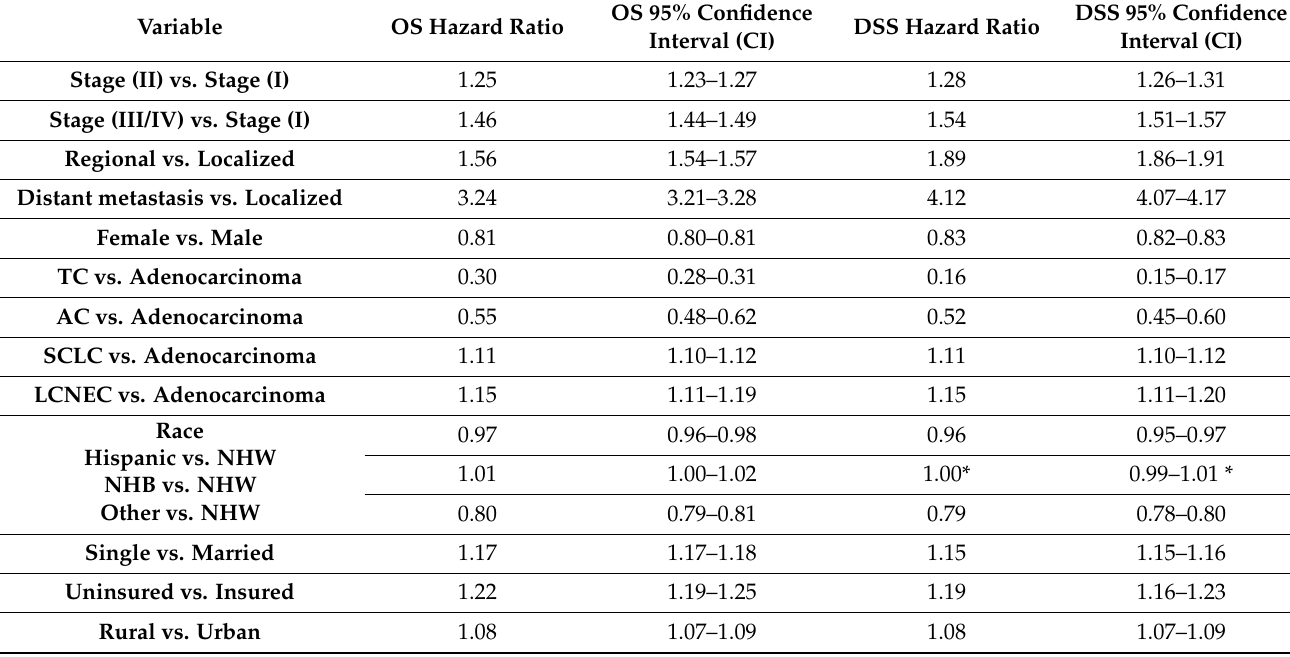
Table 2. Multivariable Cox proportional hazards regression model highlighting OS and DSS in lung cancer